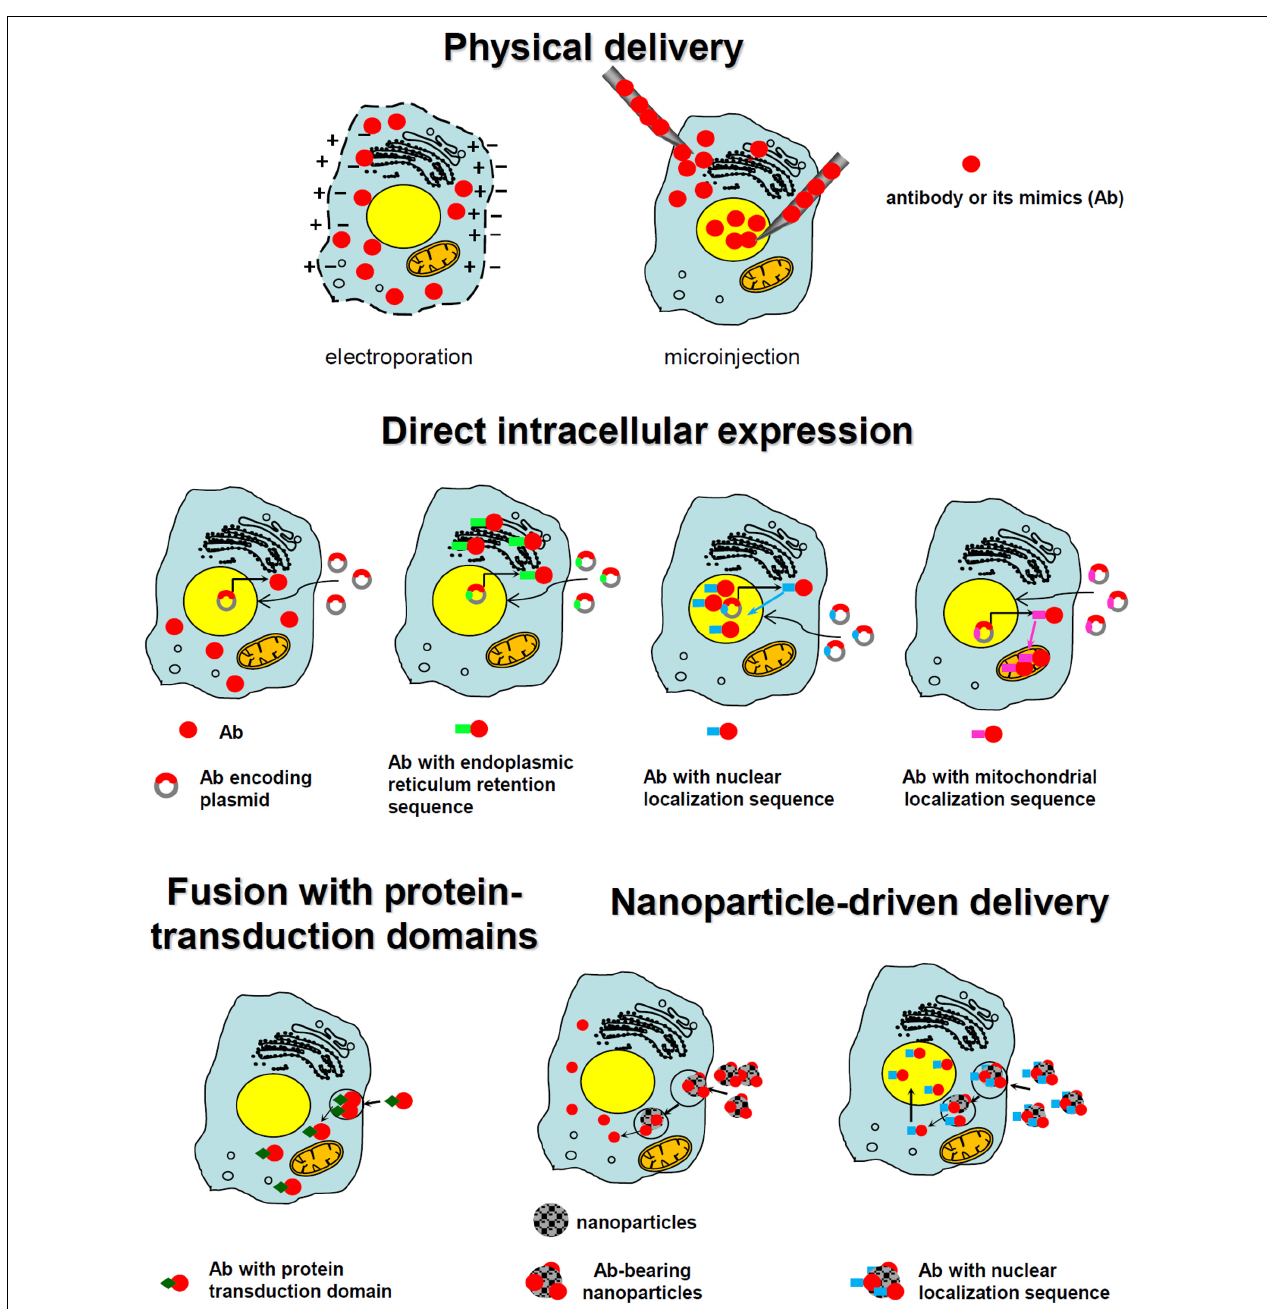
FIGURE 2 | Schematic presentation of the main approaches utilized for the intracellular targeting of antibodies.